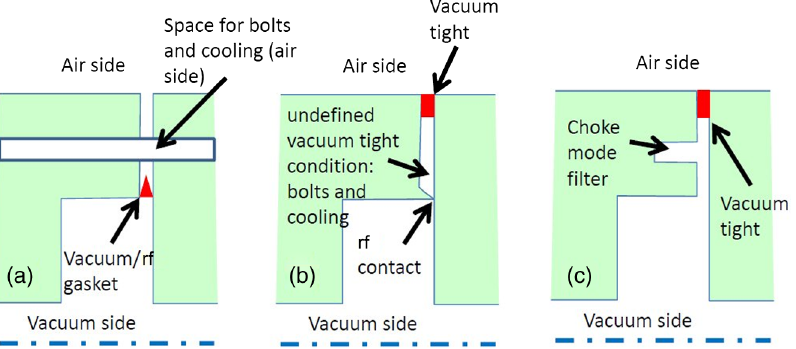
FIG. 26. Possibility of brazing-free realizations of rf structures: (a) vacuum-rf gasket; (b) rf contact and vacuum tight split in two different regions; (c) choke mode solution. TABLE II. Pros and cons of the different brazing-free techniques represented in Fig. 26. Brazing-free technique PROS